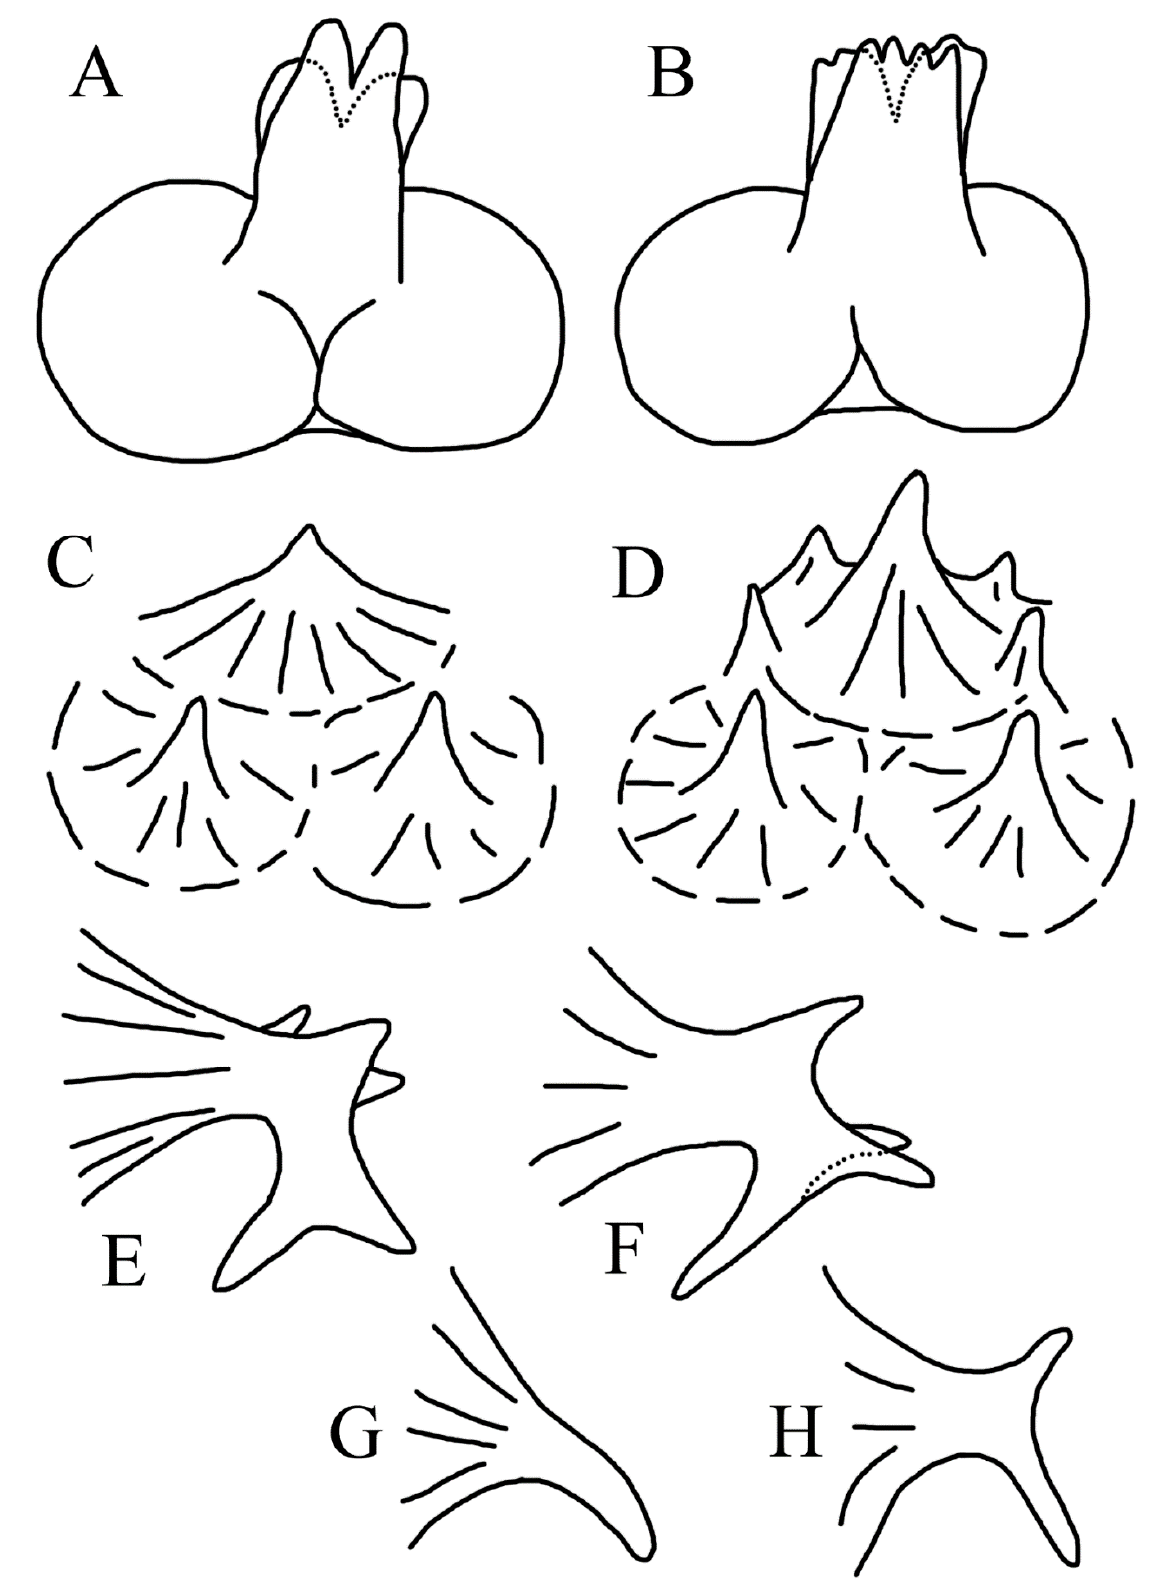
Figure 5. Esca and squamation of H. bathyoreos Bradbury, 1988. ( A , B) . Esca. ( C , D) . Rostrum. ( E , F) . Subopercular tubercles. ( G ). Tubercle on tail. ( H ). Tubercle on disk margin. ( A , C , E , G ). From AMS I.27038-001, 28.8 mm SL. ( B , D , F , G ). From AMS I.30738-001, 57.2 mm SL.